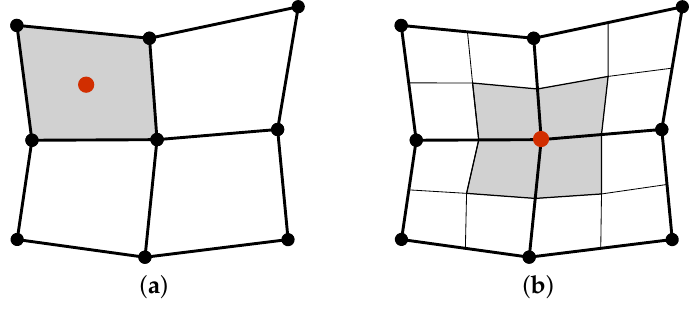
Figure 1. Control volumes representation for ( a ) cell-centered scheme and ( b ) vertex-centered scheme.